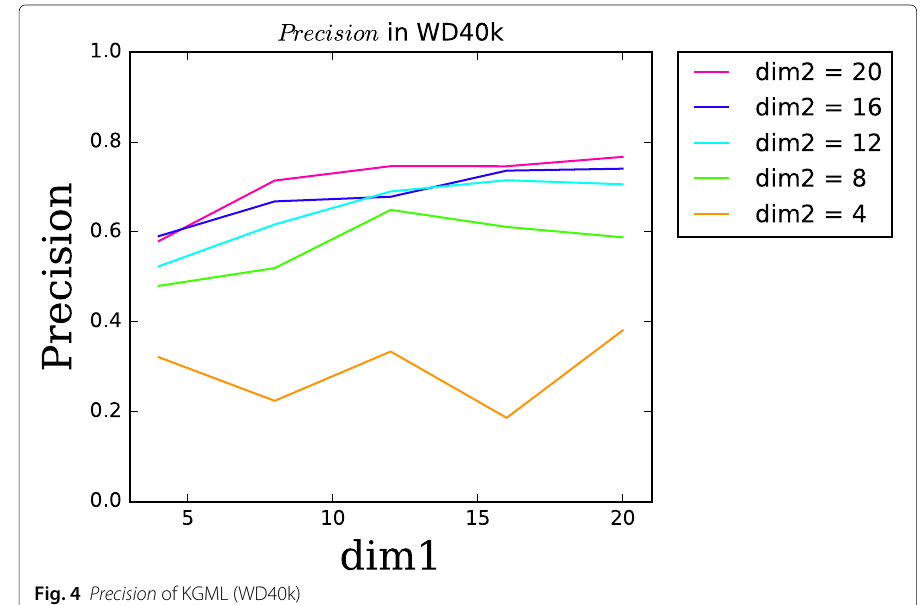
Fig. 4 Precision of KGML (WD40k)